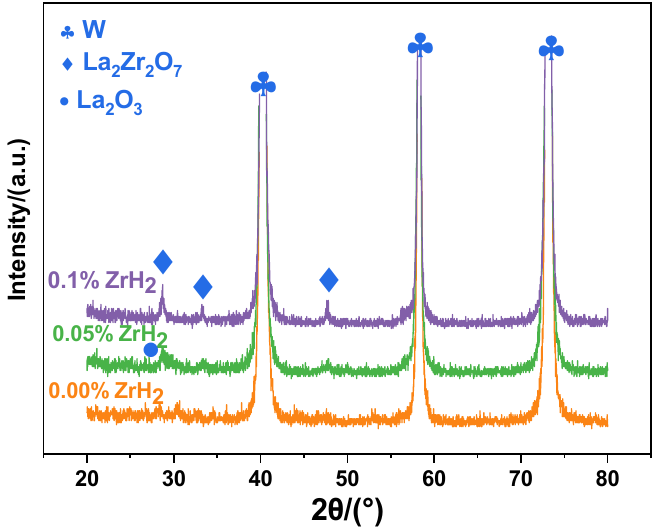
Figure 2. XRD pattern of different samples.